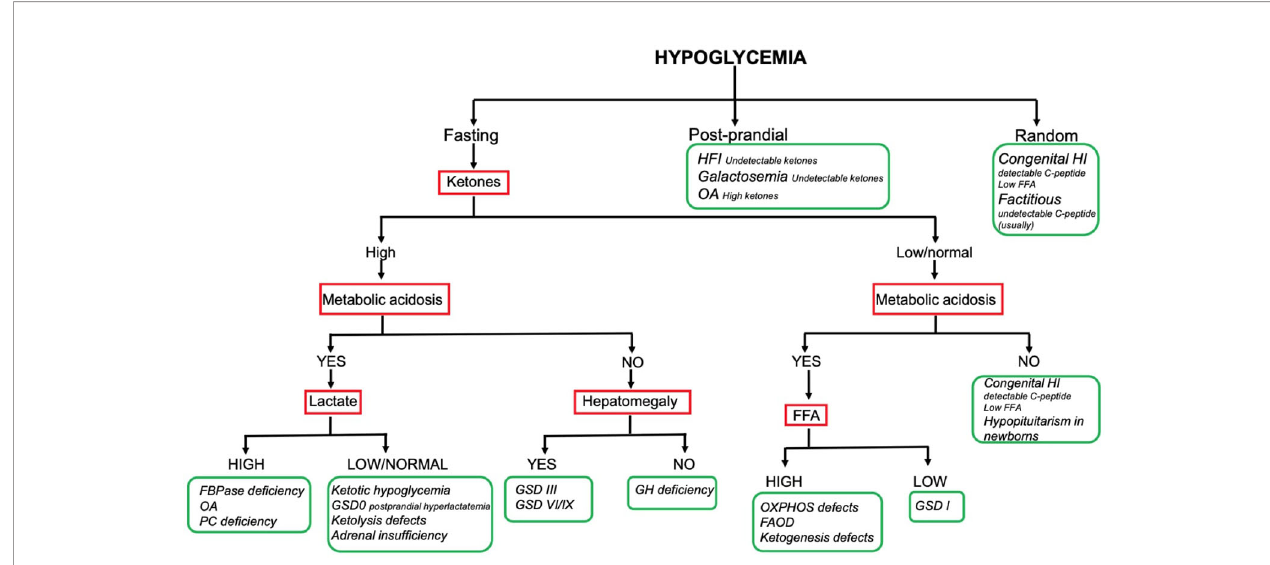
FIGURE 2 | Hypoglycemia diagnostic fl